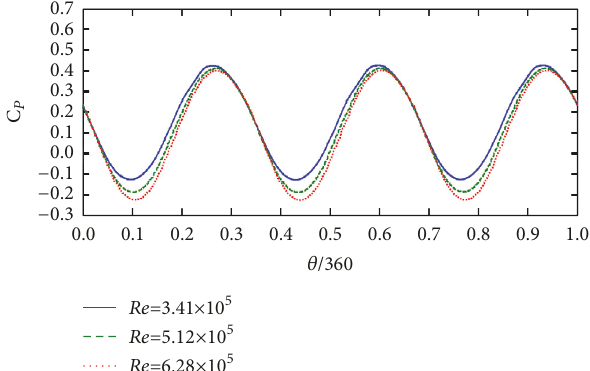
Figure 10: Power coefficient versus azimuth angle for the three considered Reynolds number at 𝜓